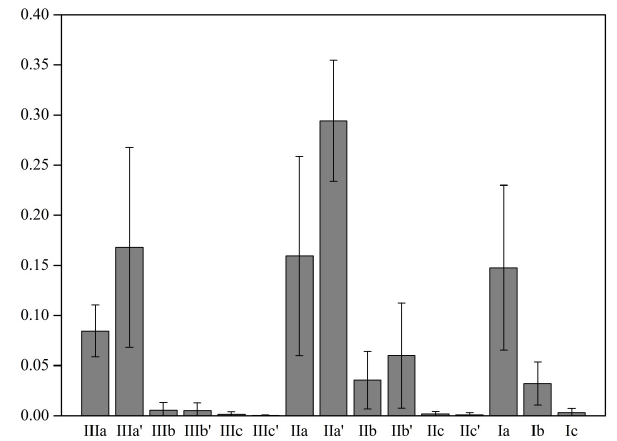
Figure 3. Average ( n = 27) fractional abundance of brGDGTs in surface soils of the QTP.